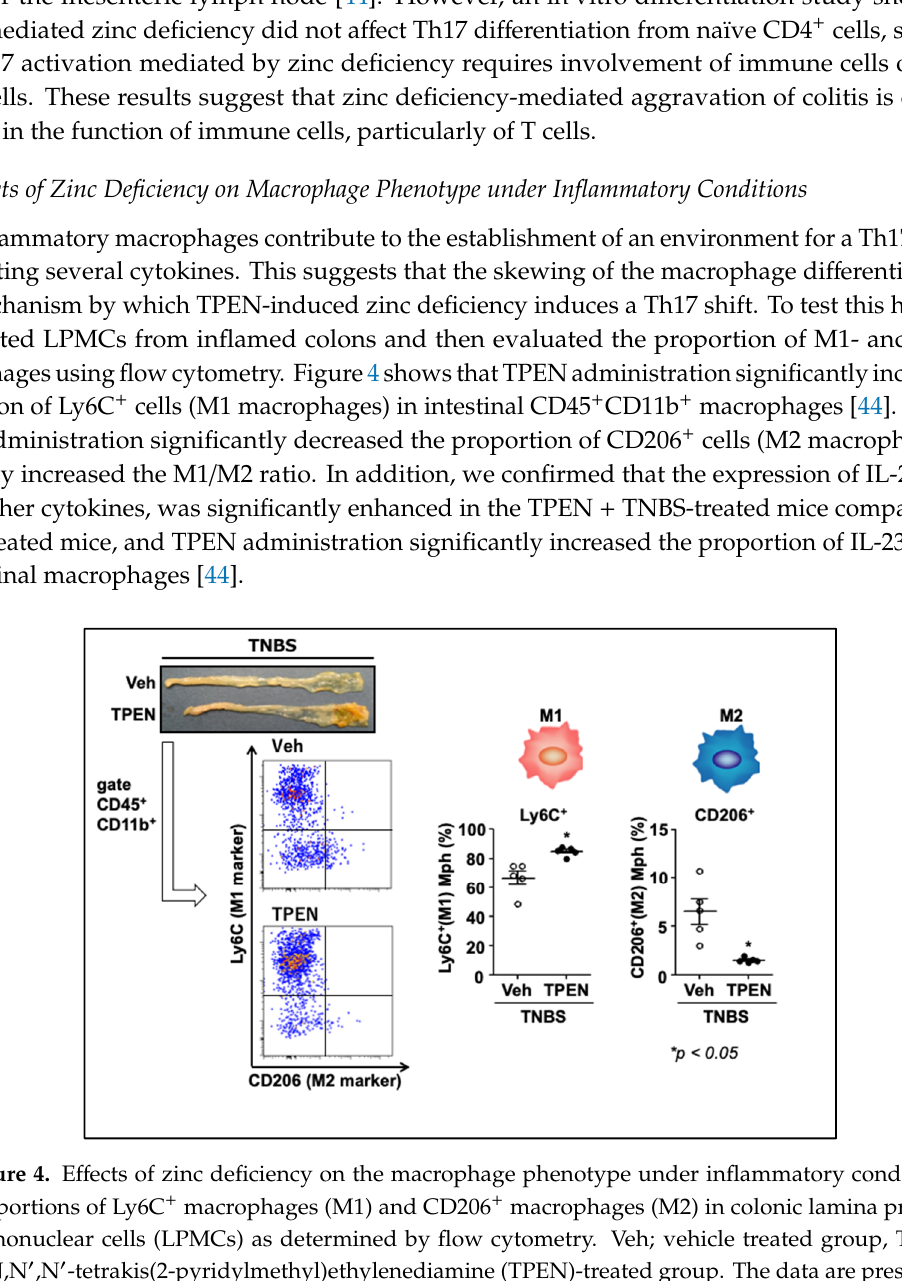
Figure 5. Zinc-mediated regulation of M1/M2 macrophage activation. In zinc-deficient macrophages, interferon-regulatory factor 5 (IRF5) translocates into the nucleus and induces IL- 23p19 expression, thereby promoting Th17 differentiation from naïve T cells. Zinc deficiency- induced aggravation of inflammation is associated with a loss of GATA-3 and IL-4 expression and anti-inflammatory M2 macrophages. 5. Zinc and Protein Metabolism in Chronic Liver Disease Liver cirrhosis is a late-stage chronic liver disease that can cause various complications due to decreased hepatic function and portal hypertension. The liver is the principal organ responsible for metabolizing nutrients. Thus, liver cirrhosis leads to defective nutrient metabolism, which in turn can cause complications and worsen prognosis. Of the three major categories of nutrient metabolism (protein, lipid, glucose), protein metabolism plays an important role in albumin and prothrombin synthesis and in ammonia